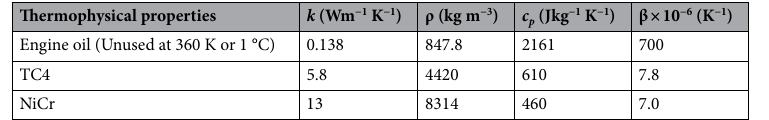
Thermophysical properties